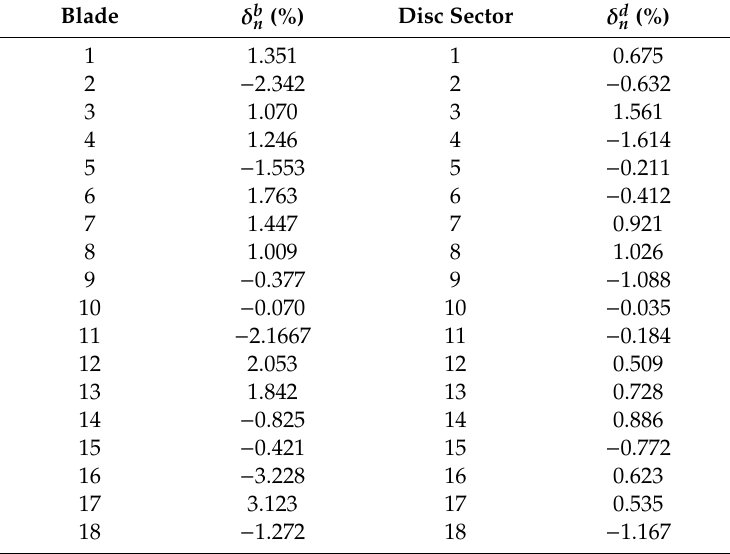
Table 2. The mistuning parameters of the blade and disc.